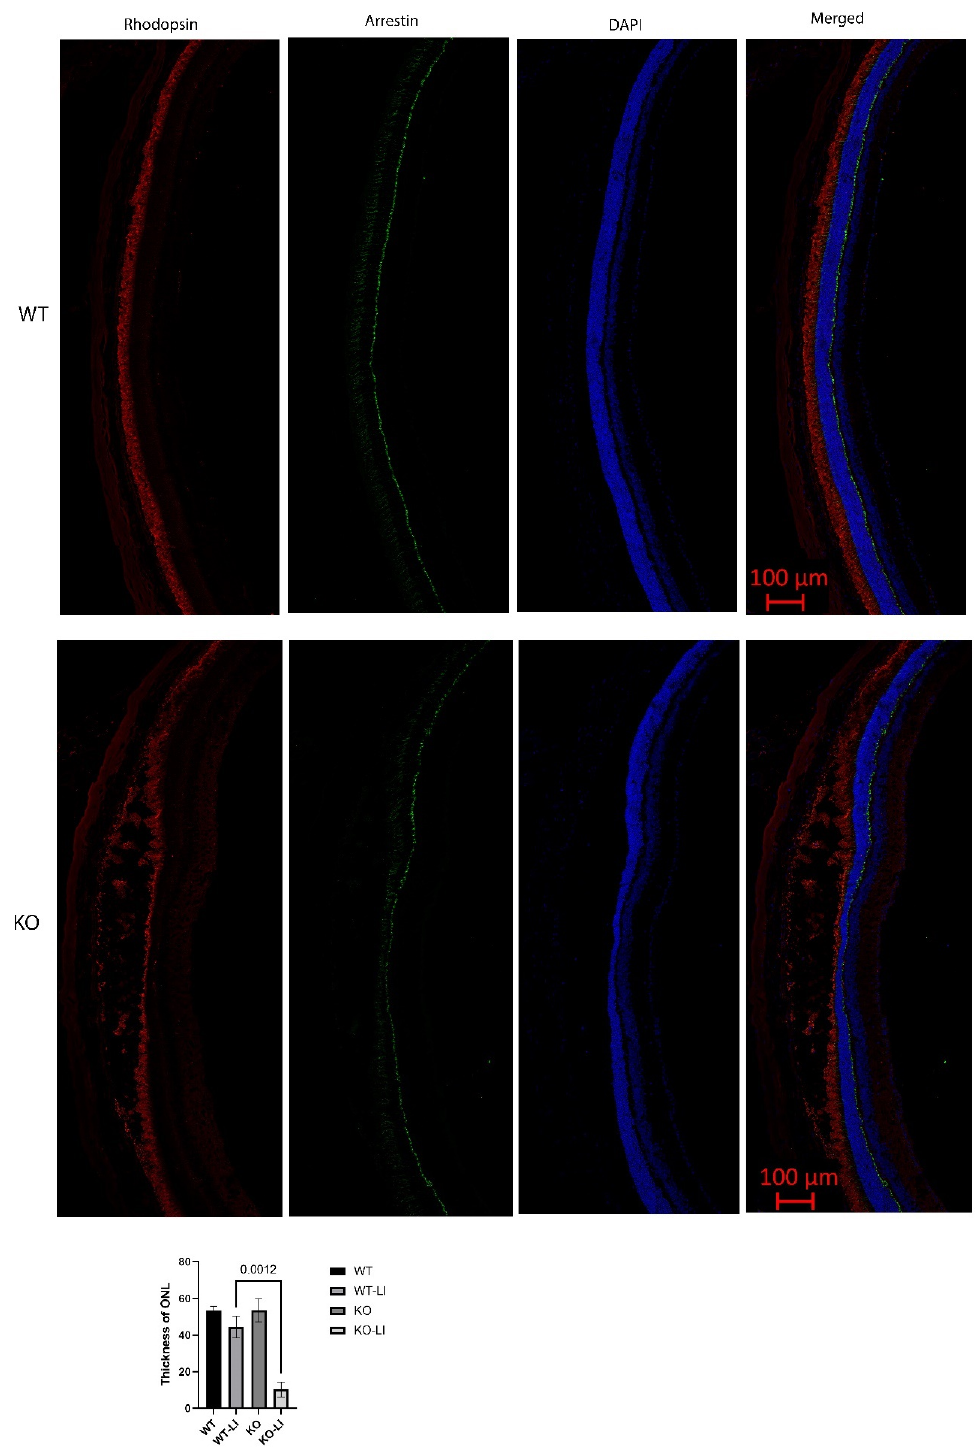
Figure 10. Immunofluorescence staining of retinal sections 7 days after light-induced injury. Rod photoreceptors, marked with rhodopsin (red), were reduced, damaged, and in disarray. Cone pho- toreceptors, marked with arrestin (green), remained largely intact. Quantification of ONL thicknesses of 6 KO and 10 WT mice shows a statistically significant decrease in the KO as compared to the WT in the dorsal retina, which is the region exposed to light, seen in the center of the retinal sections. LI: light